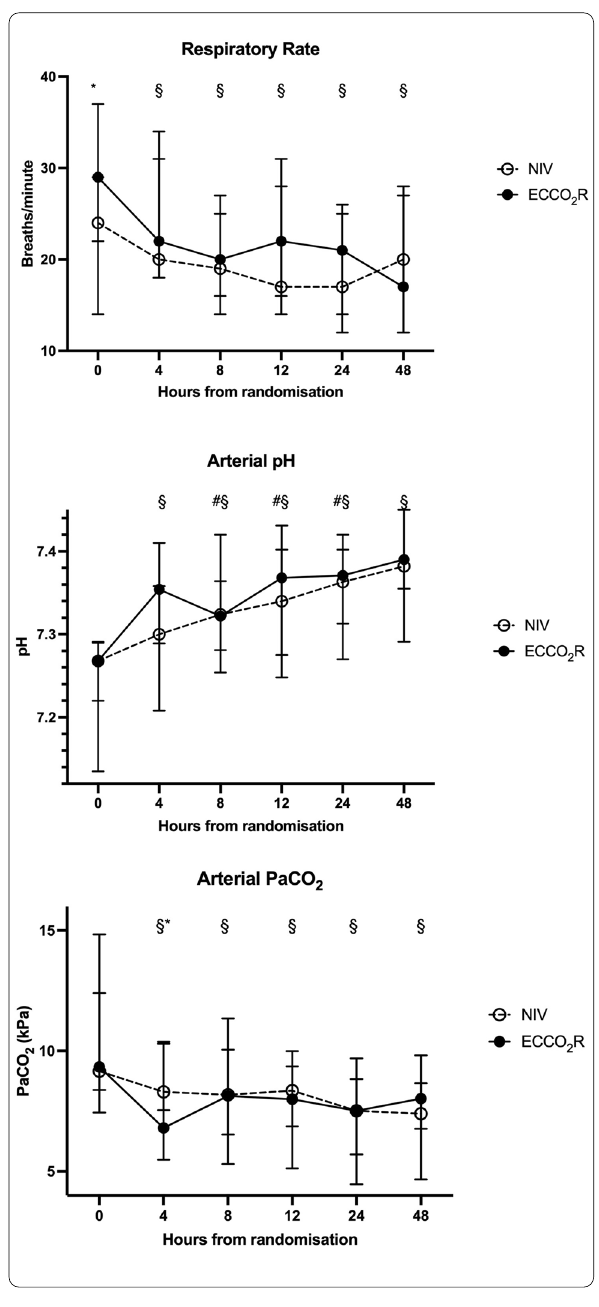
Fig. 2 Respiratory rate, arterial pH and PaCO 2 over the first 48 h. a : Respiratory rate over the first 48 h (* statistically significant difference between the NIV and ECCO 2 R groups ( p < 0.05); ^ statistically significant difference over time in the ECCO 2 R group compared with baseline (time 0) ( p < 0.05)); b : Arterial pH over the first 48 h (* statistically significant difference between the NIV and ECCO 2 R groups ( p < 0.05); ^ statistically significant difference over time in the ECCO 2 R group compared with baseline (time 0) ( p < 0.05); # statistically significant difference over time in the NIV group compared with baseline (time 0) ( p < 0.05)); c : PaCO 2 over the first 48 h (* statistically significant difference between the NIV and ECCO 2 R groups ( p < 0.05); ^ statistically significant difference over time in the ECCO 2 R group compared with baseline (time 0) ( p < 0.05); # statistically significant difference over time in the NIV group compared with baseline (time 0) ( p <